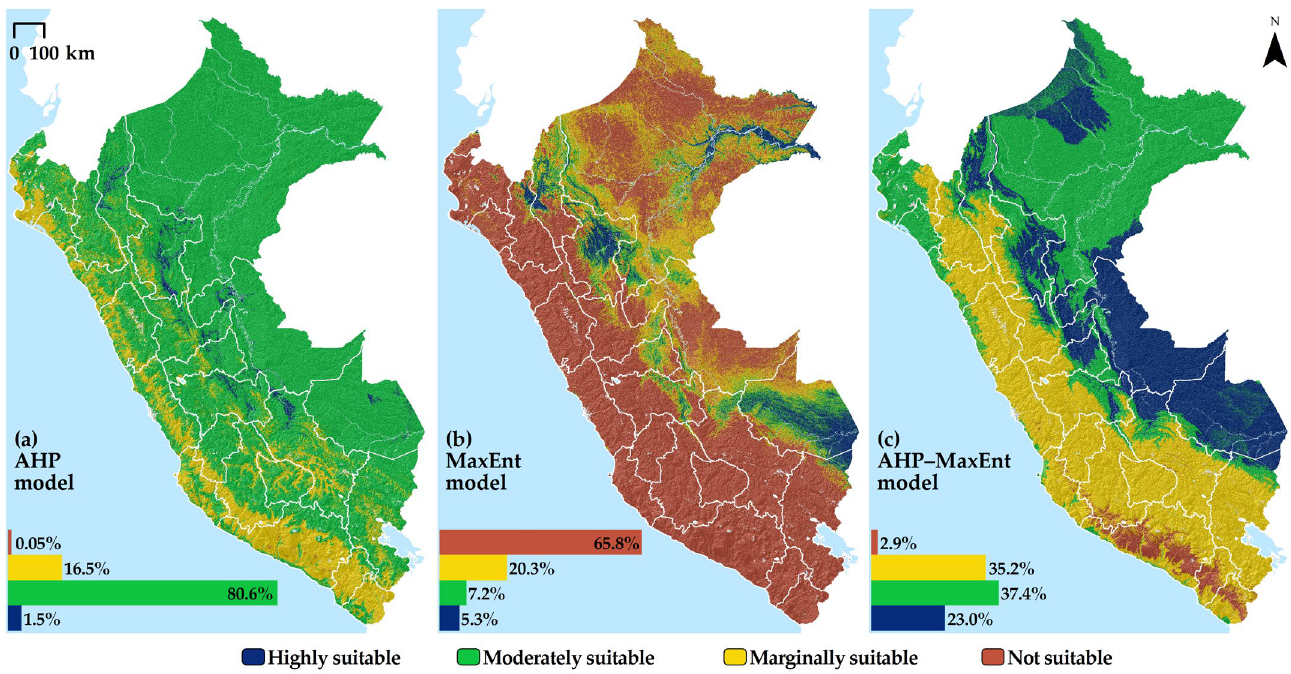
Figure 5. Land suitability map for cocoa cultivation in Peru, AHP model. Table 4. ‘Highly suitable’ area (km 2 ) of land suitability for cocoa cultivation in Peru, based on re- gions and modeling approaches .